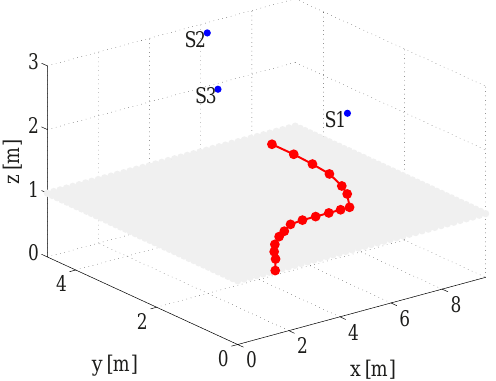
Figure 1. Three receivers are placed at 3m height, shown as blue points. The path of the moving transmitter (18 positions) is shown as red points, joined by a red solid line. The plane of the moving transmitter is discretized in 40 × 40 source locations shown in grey.